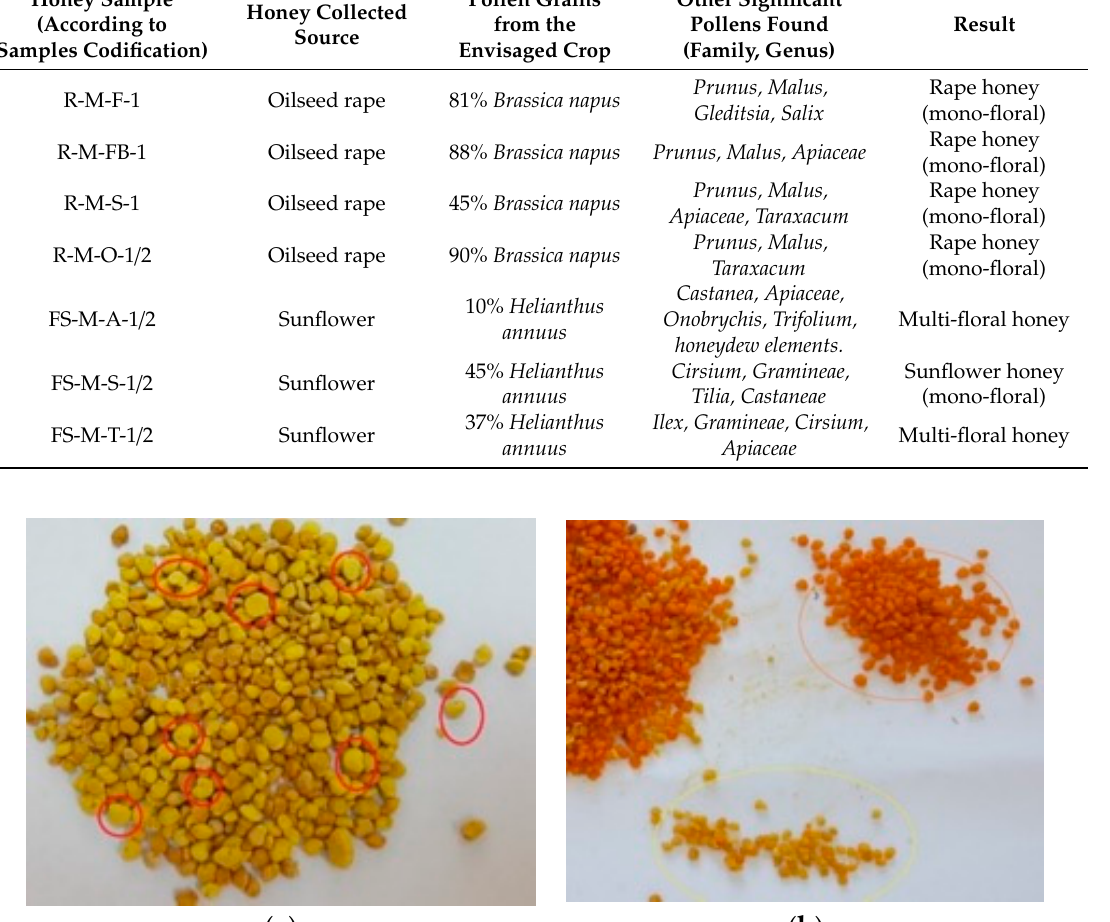
Figure 3. Microscopic view of the pollen grains used to confirm the studied selected samples. ( a ) The oilseed rape ( Brassica napus ) pollen had a ~24 µm grain with a round tricolpate form and grooves at the rounded tip, covered with a membrane, sometimes with small granular residues; the exine had a finely cross-linked surface. ( b ) The corn ( Zea mays ) pollen grain was a ~99 µm granule with a single porous opening, the exine and the intine being thin membranes and the cytoplasm appearing granular with numerous small starch formations. ( c ) The sunflower ( Helianthus annuus ) pollen grain was ~35 µm and was a trickled grain, having a surface covered in thin and long thorns that protruded to the pores. The used equipment: Olympus, Quick Photo camera 3.1., ×200: Photos© Institute for Beekeeping Research and Development, Bucharest. Pollen mono-floral selection, a time consuming activity, was possible only when the minimum sample quantity requested by laboratory was low. The minimum quantities of the samples requested by the two laboratories were a minimum of 10 g at the ANSES laboratory and a minimum of 250 g at Quality Services International (QSI) laboratory. The minimum quantity of 10 grams (e.g., ANSES laboratory) permitted a better approach in the sample preparation, thus providing a better analysis of the pollen origin regarding the plant species. The process of collection and selection of representative samples was a key stage in the neonicotinoid identification and quantification. Following these selection steps, 50 samples were prepared and sent to the laboratories, as follows: honeybees—10 samples; honey—15 samples; and pollen—25 samples. 2.4. Sample Preservation, Codification, Packing and Sending to the Accredited Laboratories According to Specific Requirements After the collection and transportation to the central laboratory of the Institute for Beekeeping Research and Development, all the samples were preserved at − 18 °C.